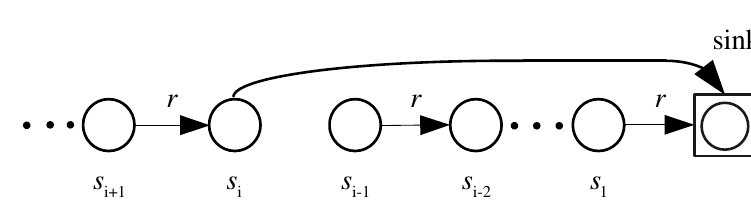
Figure 4. Unlinked